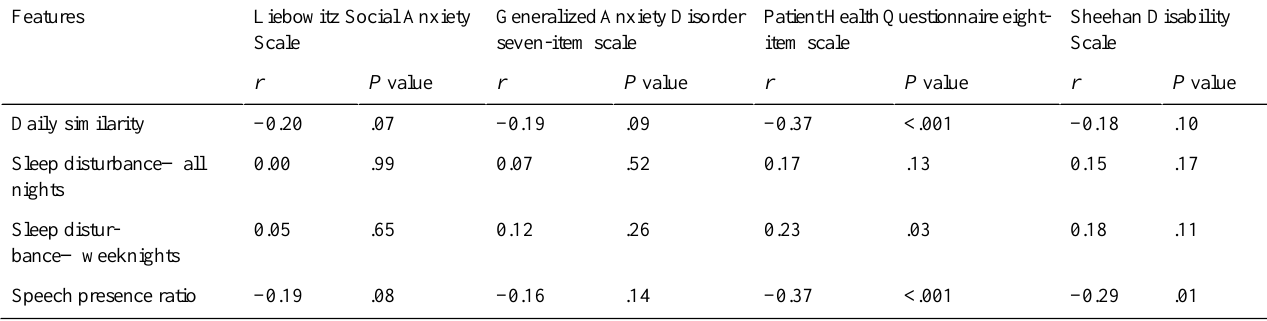
Table 4. Pearson correlation between objective audio features and self-reported measures of anxiety and depression (n=84).